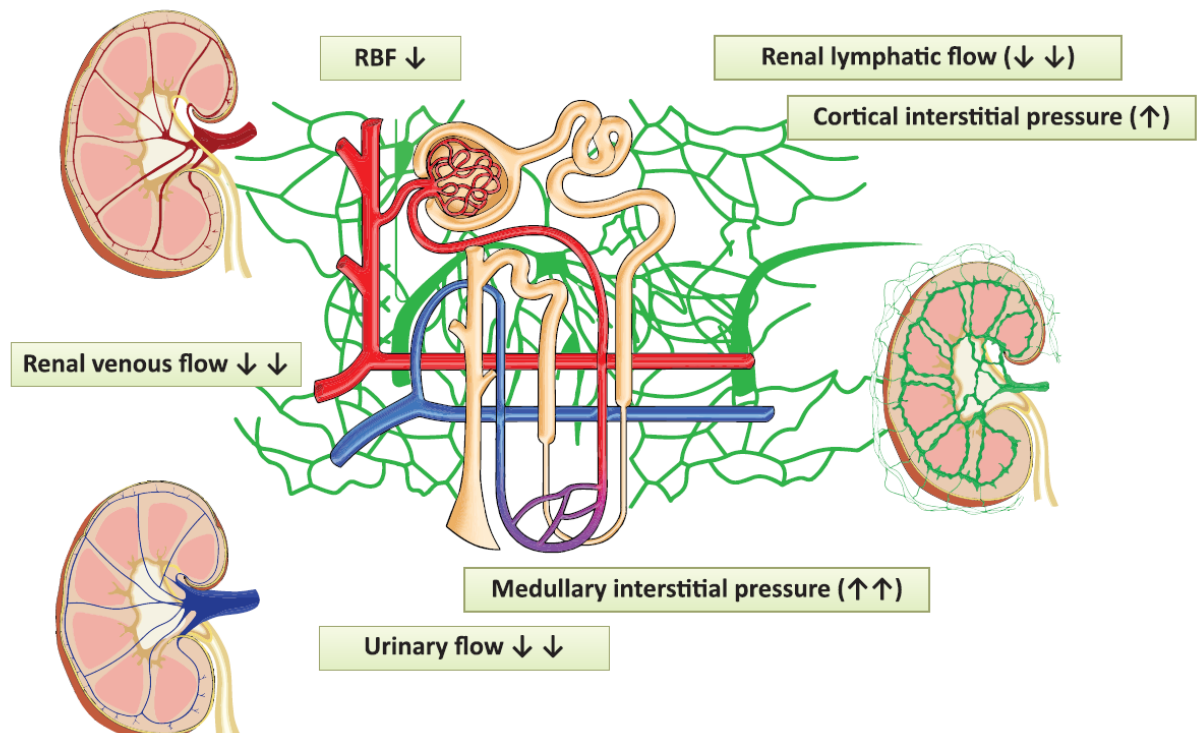
Figure 5. The pathophysiological changes evoked by laparoscopy, which can contribute to the development of acute kidney injury. Red vessels: arteries; blue vessels: veins; purple vessels: connection vessels between arteries and veins; yellow tubes: urine conducting system; green vessels: lymphatic network; RBF: renal blood flow.